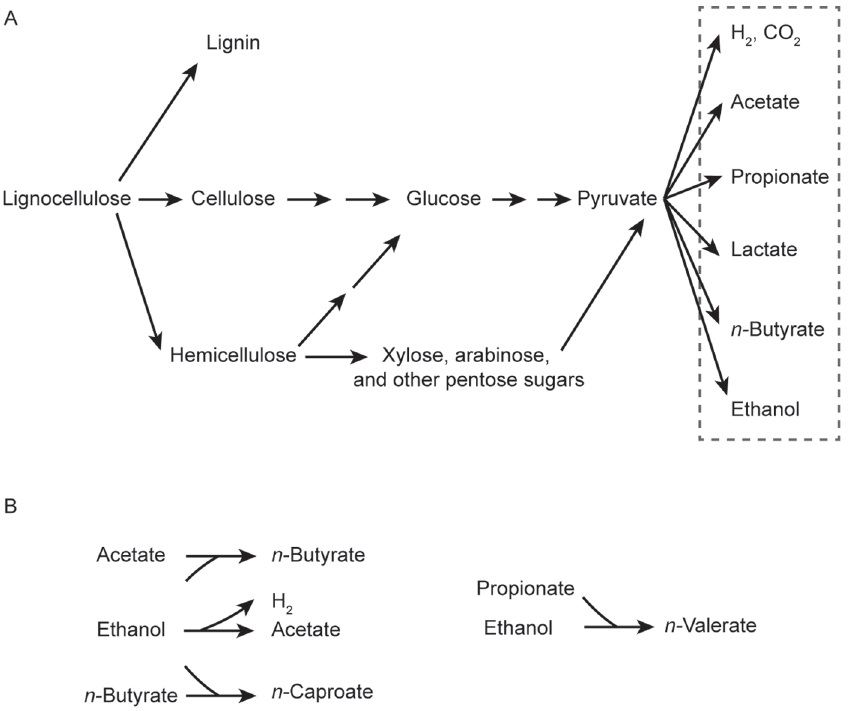
Figure 1. Generalized pathways underlying the conversion of lignocellulose to short chain fatty acids in the carboxylate platform. A) During primary fermentation, pentose and hexose sugars are converted into pyruvate, which may be converted downstream into a variety of primary products (outlined in gray). B) These primary products may undergo secondary fermentation, including chain elongation with ethanol. Multiple arrows indicate that several steps may be involved in the conversion of substrate to